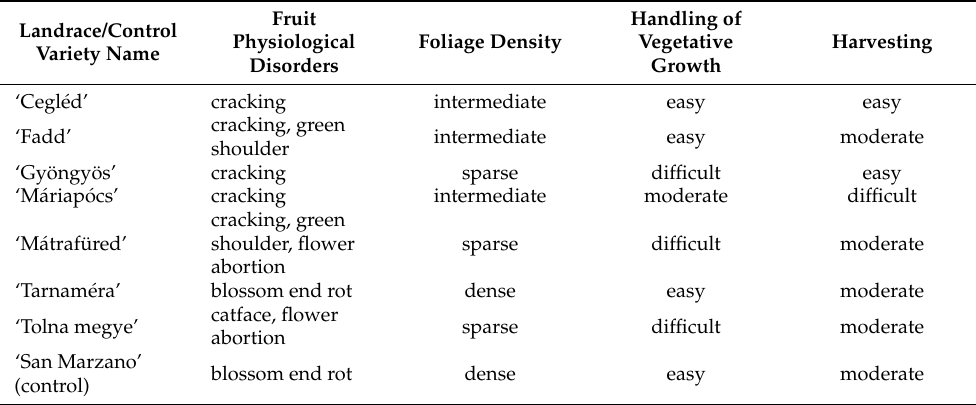
Table 12. Highlighted subjective observations regarding indeterminate tomato landraces and control varieties experienced on both experimental